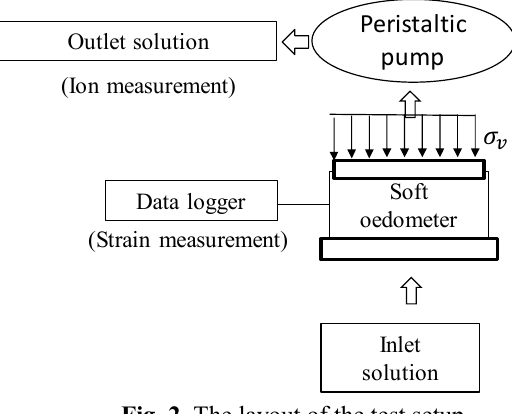
Fig. 2 . The layout of the test setup.